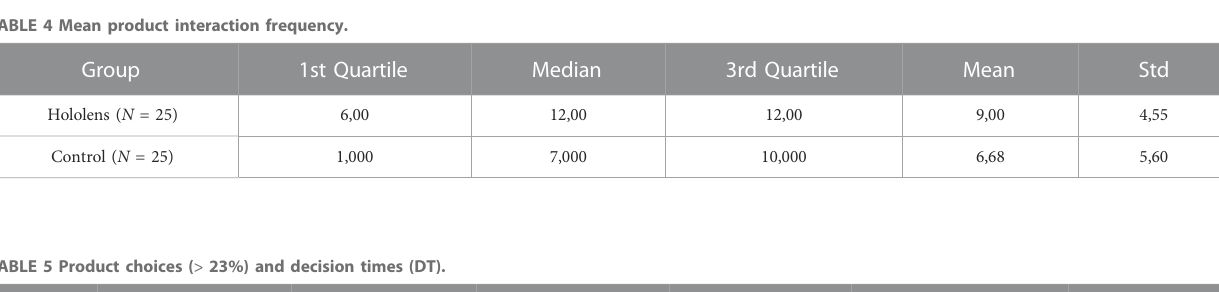
TABLE 5 Product choices ( > 23%) and decision times (DT). Product Hololens (Abs Freq.)